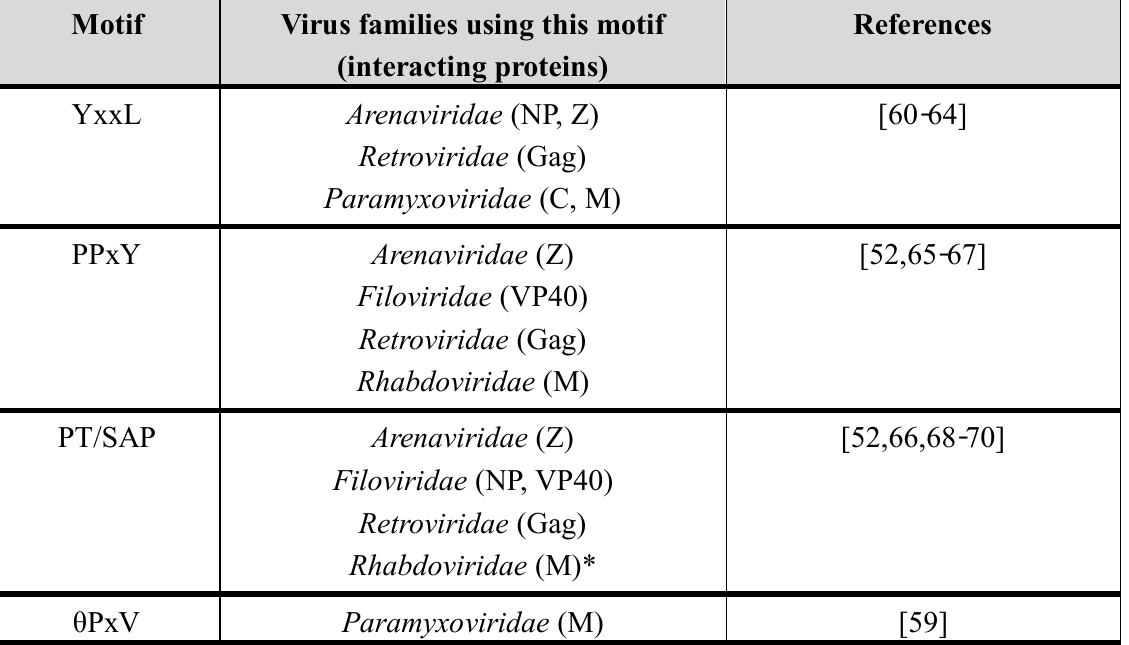
Table 2. Late-domain motif usage among different virus